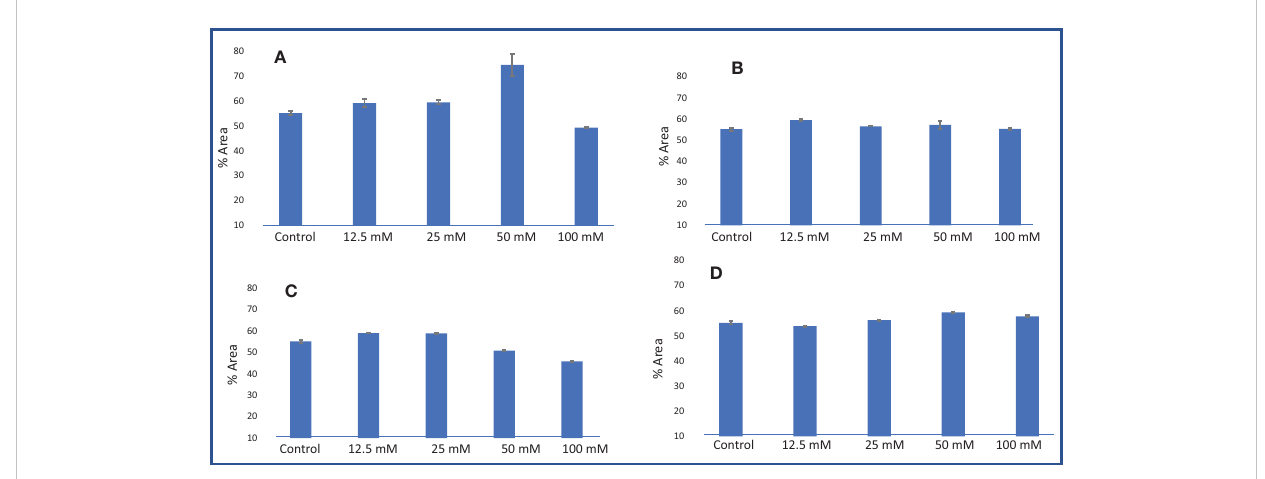
FIGURE 11 Carvone % area obtained from GC – MS analysis in an M. longifolia essential oil sample under salt stress condition. (A) Different concentrations of NaCl; (B) Different concentrations of KCl; (C) Different concentrations of MgSO 4 ; and (D) Different concentrations of CaCl 2 . The data are represented as mean ± standard deviation (n = 3).